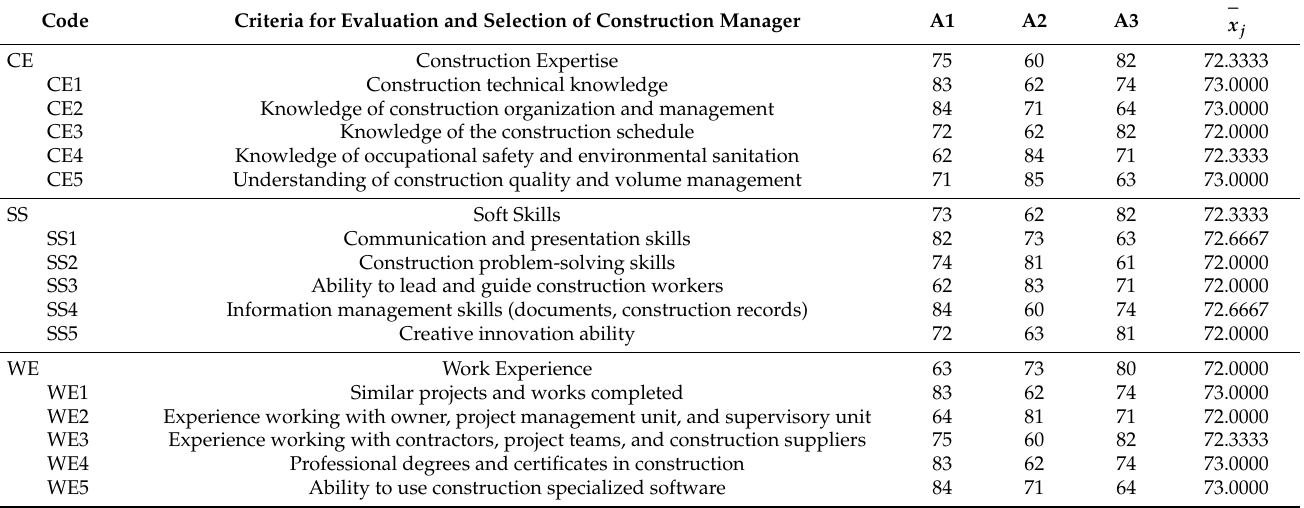
Table 3. The average solution of criteria for the evaluation and selection of a construction manager.